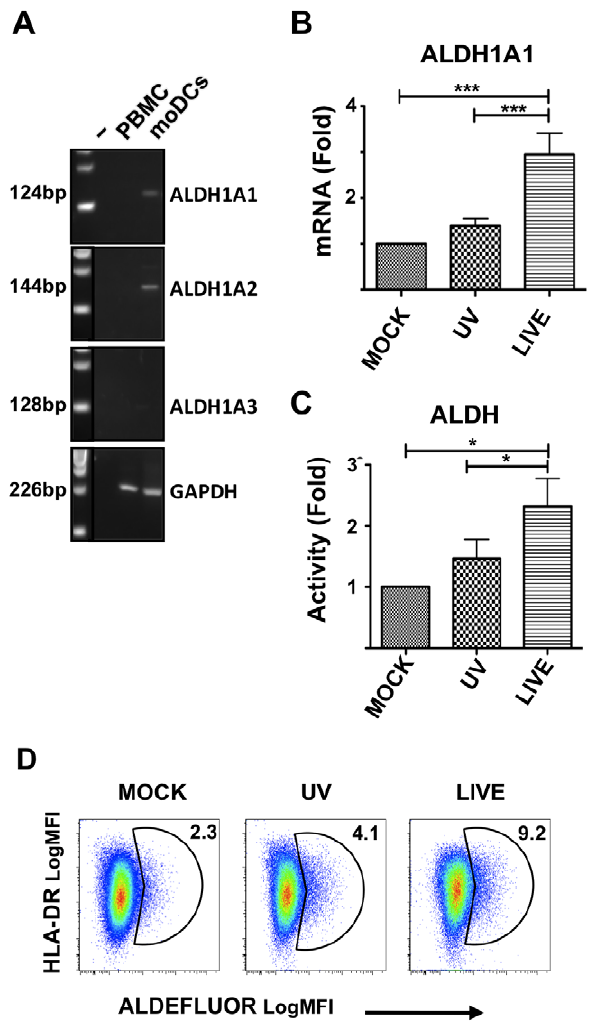
immature moDCs and PBMCs by RT-PCR. Results shown are represen- tative of data from 2 different donors. A negative control ( 2 ) without DNA was included to control for contamination. GAPDH was amplified in each sample as an internal PCR and loading control. B) The fold changes (mean 6 SEM, 13 independent experiments) in ALDH1A1 mRNA of LIVE- and UV-HSV-2-treated moDCs (24 h post treatment) are shown relative to mock-treated moDCs (set as 1). C) The fold changes (mean 6 SEM, 5 independent experiments) in the percentage of ALDEFLUOR positive (ALDH enzymatic activity) moDCs treated with LIVE or UV-HSV-2 (24 h post treatment) are shown relative to mock- treated moDCs (set as 1). D) Gating strategy for ALDH enzymatic activity in mock-, UV-HSV-2-, or Live HSV-2-treated moDCs (summarized in panel C). One representative of 5 independent experiments is shown. The numbers indicate the percentage of ALDH + cells. (*p , 0.05, ** , 0.01, ***p # 0.001).